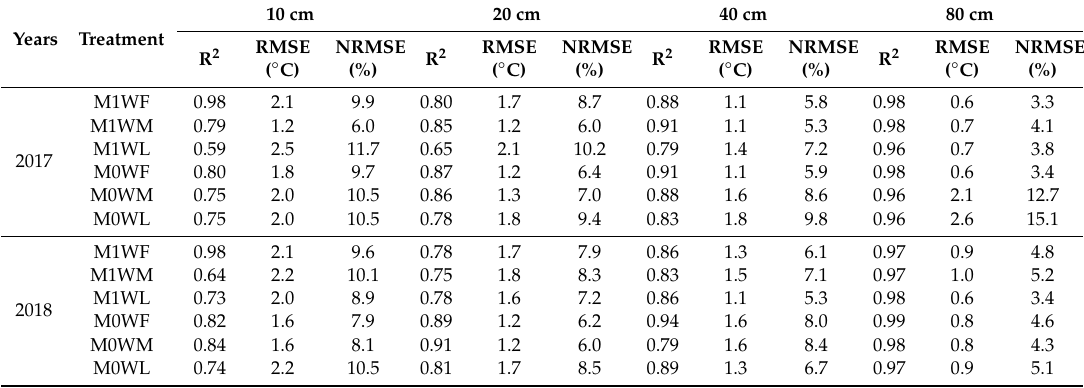
Table 7. R 2 , RMSE, and NRMSE values between the simulated and measured average daily soil temperature under di ff erent treatments in 2017 and